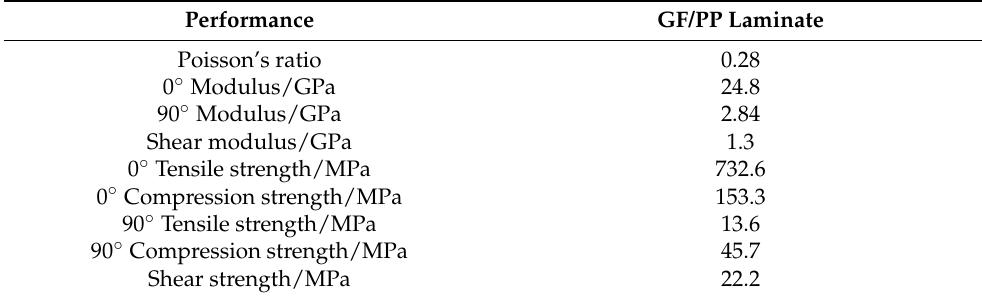
Table 5. The Mechanical properties of GF/PP